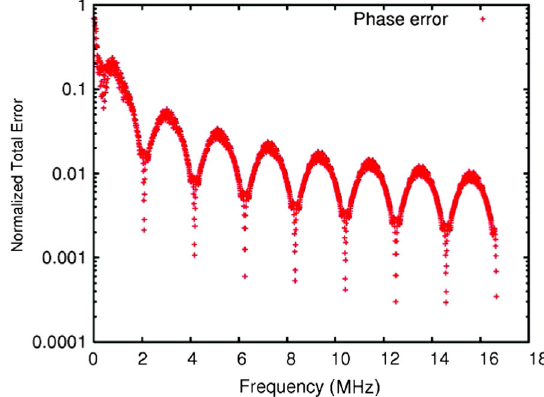
FIG. 13. Normalized phase error after filtering by the recombi- nation scheme and the ideal drive beam rf filling function vs rf phase jitter frequency.